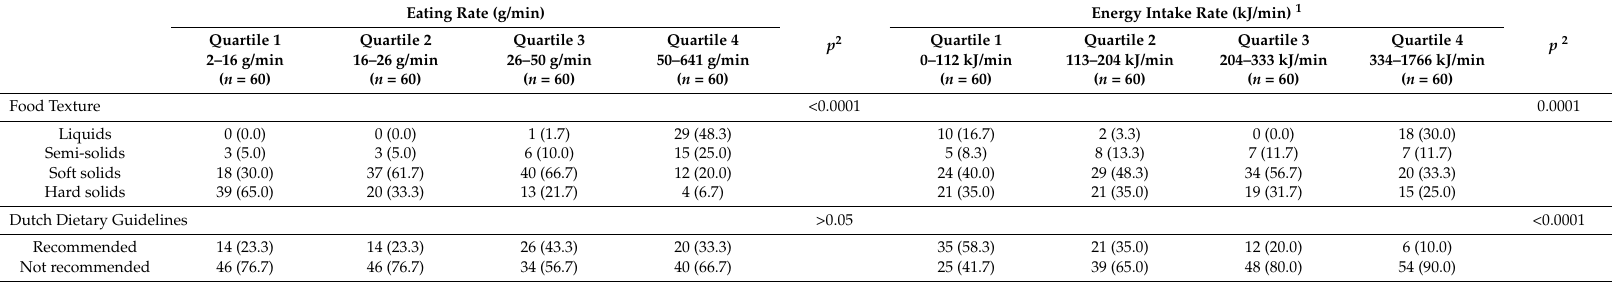
Table 2. Frequency ( n (%)) of texture groups and recommended foods in the eating rate and energy intake rate quartiles ( n =